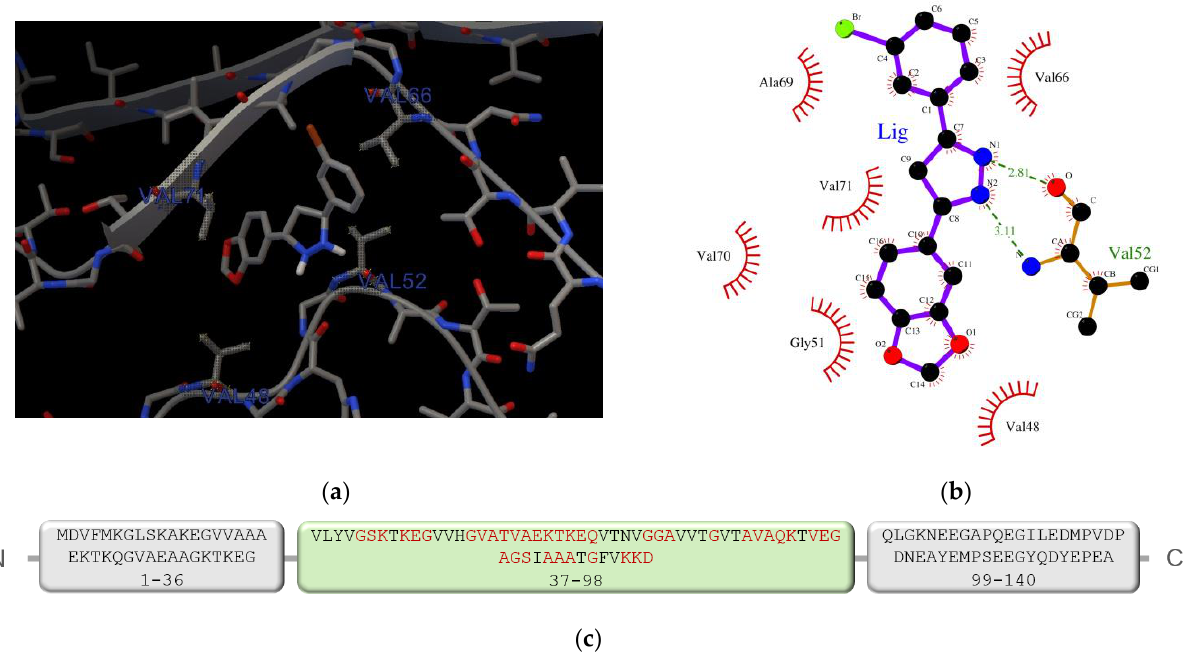
Figure 1. ( a ) Binding of the Anle138b molecule to a fragment of the alpha-synuclein monomer (PDB ID 7V4C); ( b ) chart of interactions when Anle138b binds to a fragment of the alpha-synuclein monomer (region: 37 – 98); ( c ) the amino acid sequence of AαSyn, the green box represents the region of the Val37 – Asp98 sequence for which the molecular docking experiment was performed (PDB ID 7V4C), amino acid residues that belong to the disorder-promoting set are marked in red.